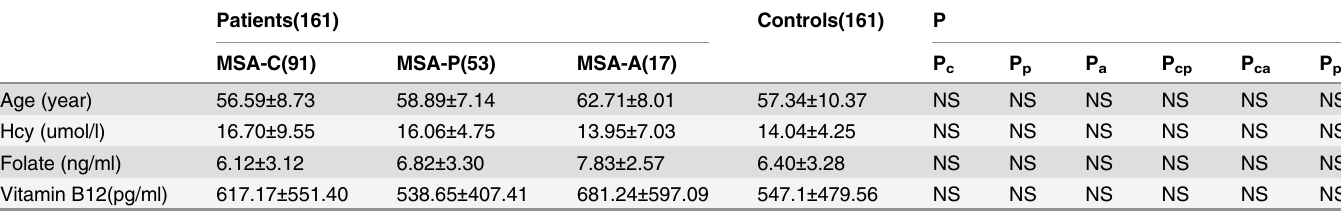
Table 2. Comparison among the different subtypes patients and